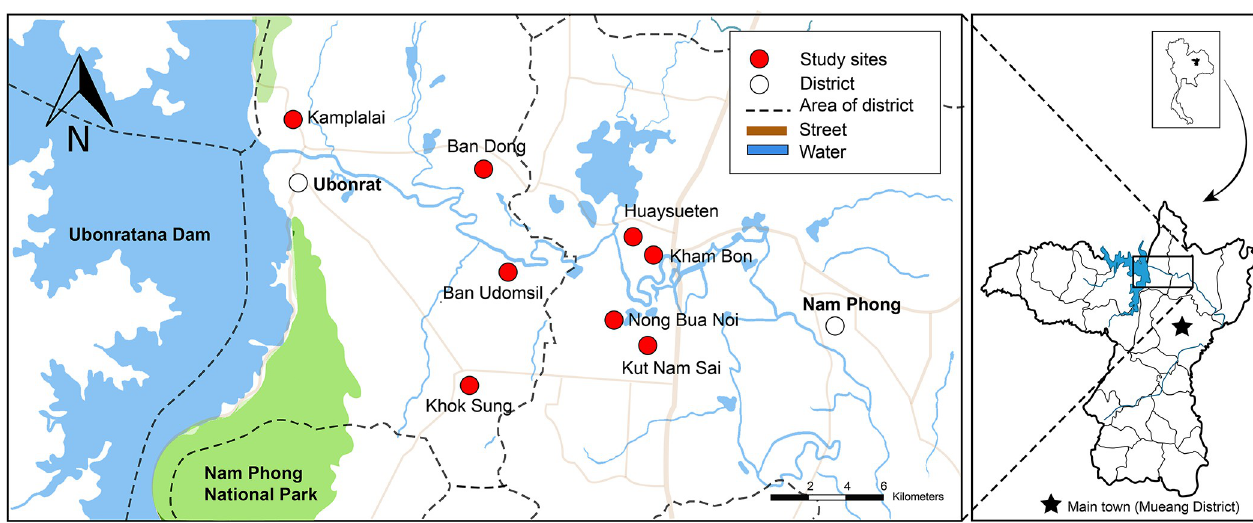
Fig 1. Geographical area of this study in Khon Kaen Province, northeastern Thailand. Map obtained from USGS National Map Viewer (public domain): http://viewer.nationalmap.gov/viewer/. The base map is visualized based on the OpenStreetMap elements tags. Reprinted from OpenStreetMap under a CC